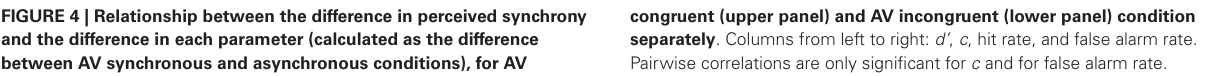
congruent (upper panel) and AV incongruent (lower panel) condition separately . Columns from left to right: d’ , c , hit rate, and false alarm rate. Pairwise correlations are only significant for c and for false alarm